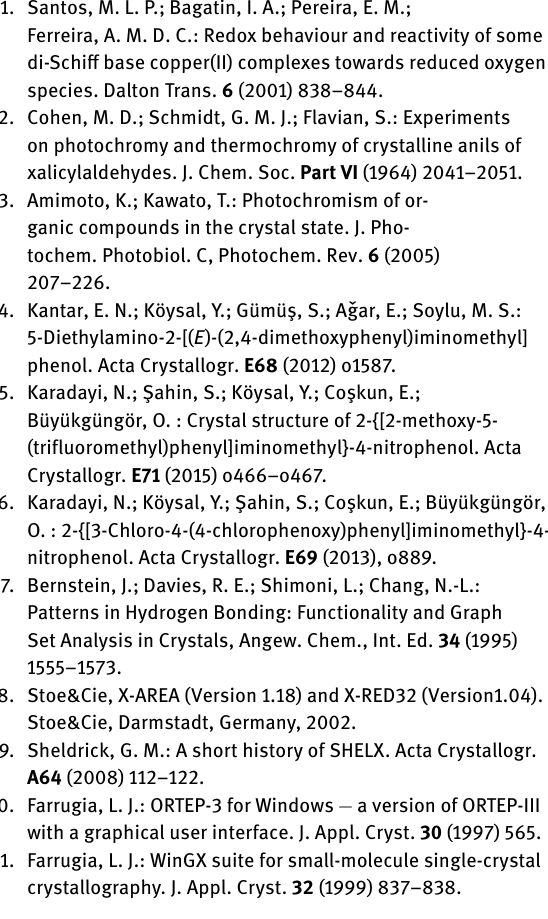
the C15—O1 bond distances are 1.288(3) Å and 1.323(3)Å, respectively. The obtained bond distances and angles are in expected normal ranges, and are consistent with our related structures